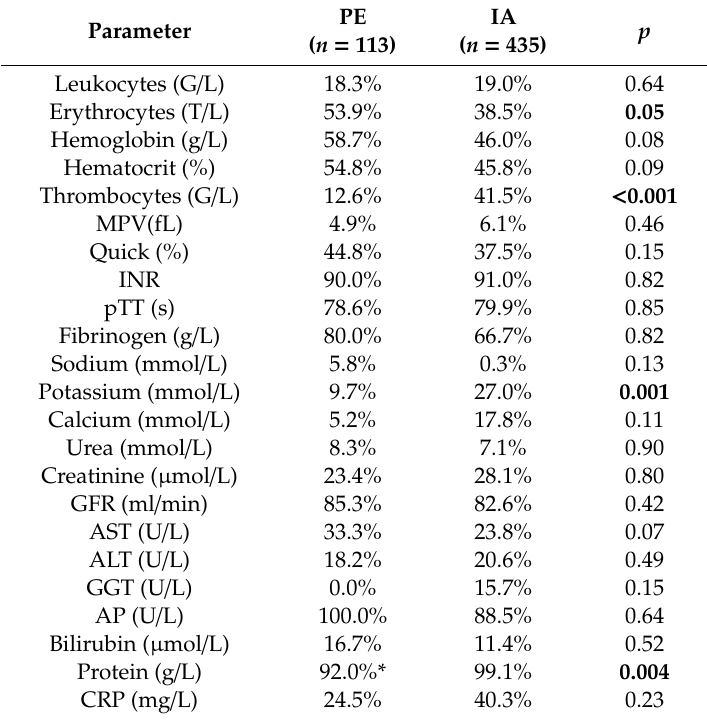
Share of patients with values below or above the pathological threshold for each parameter at last day of apheresis in each group. IA—immunoadsorption; PE—plasma exchange; MPV—mean platelet volume;